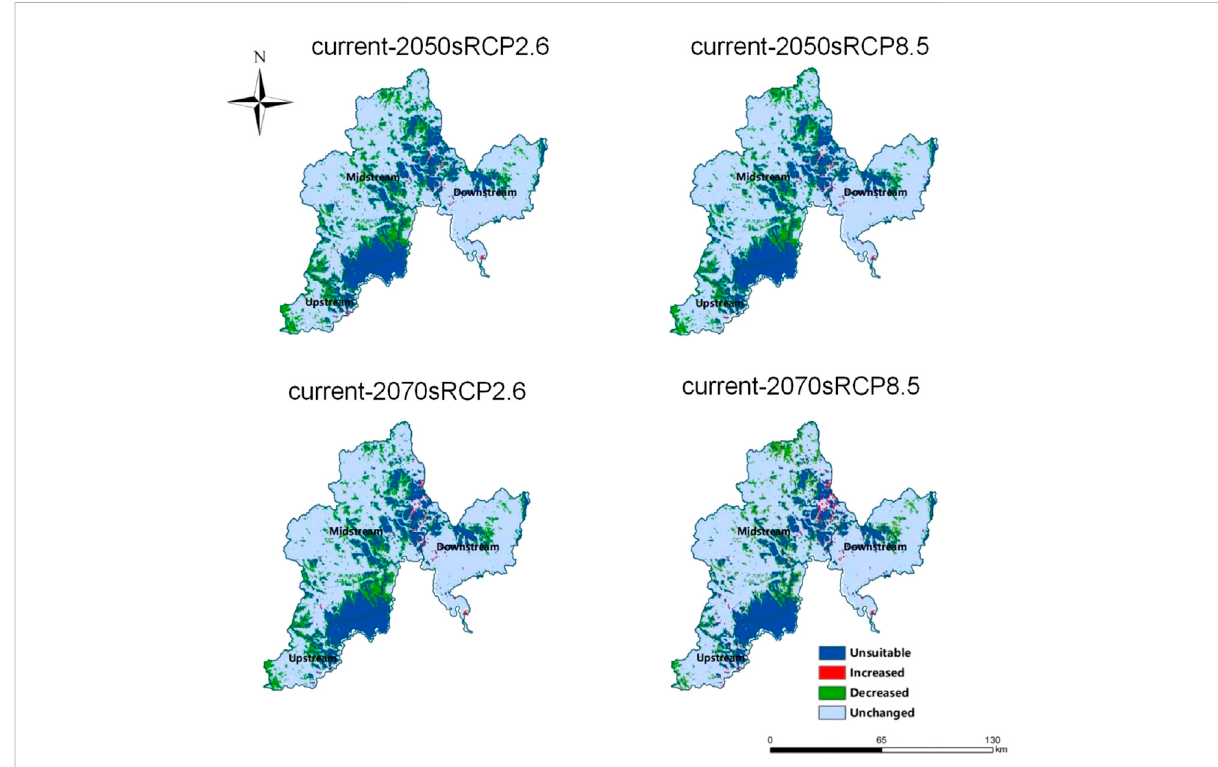
FIGURE 6 Changes of Deyeuxia angustifolia in the suitable area of the Tumen River Basin under different climate change